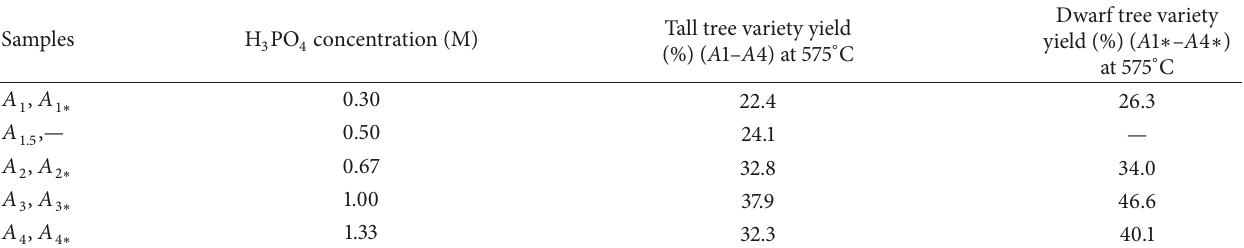
Table 4: Effect of activating agent concentration on activated carbon yield.